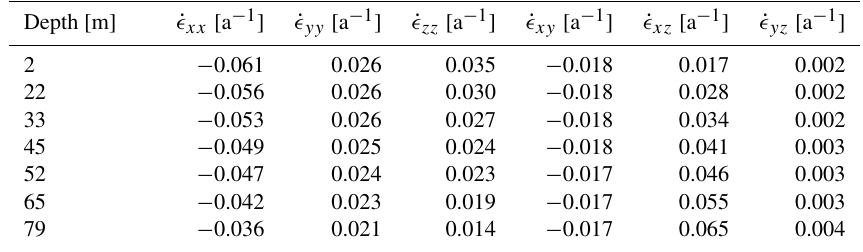
Table 2. Strain rates derived from ice flow modelling ( x – longitudinal, y – transverse, z – vertical direction). Depth